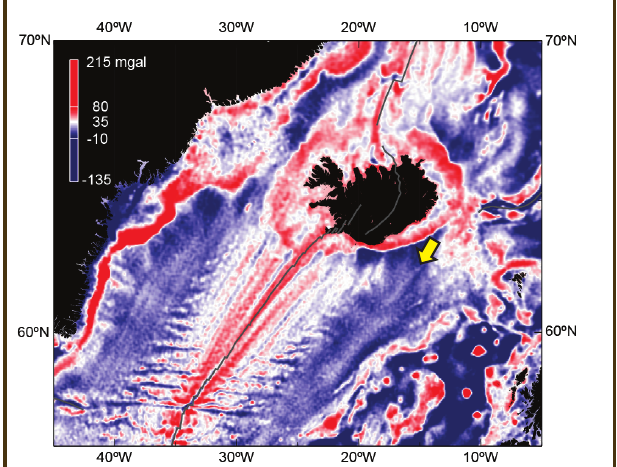
Figure 3. Gravity map of the North Atlantic Ocean showing prominent V-shaped ridges in the basement topography around the Reykjanes Ridge south of Iceland. These represent crustal thickness variations of ~2 km. The yellow arrow shows the location of thick sediment drifts deposited by northern component water flowing southwards over the Iceland-Faeroes ridge. Thinner drifts are present south of the Greenland-Iceland